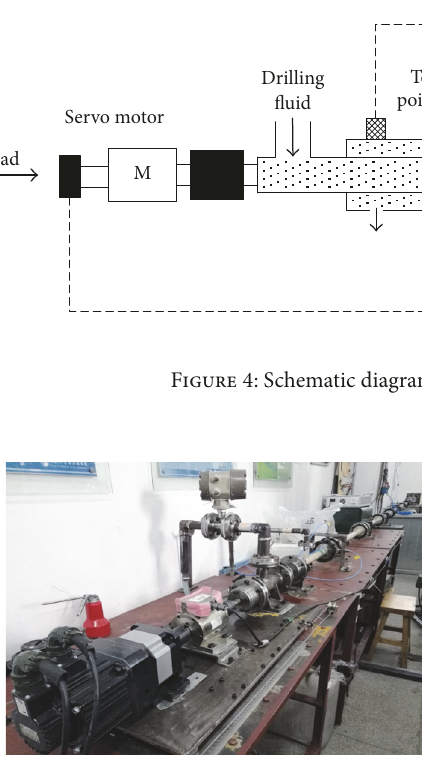
Figure 5: Experimental apparatus.